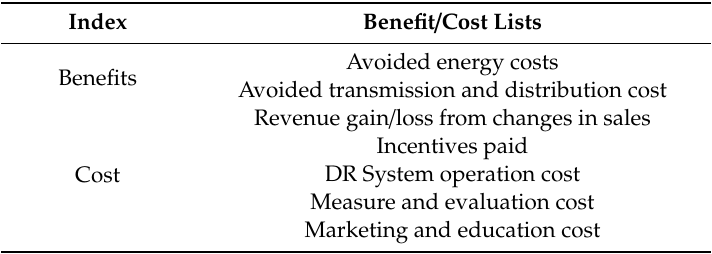
Table 2. Benefits and cost list for cost-e ff ectiveness analysis in DR